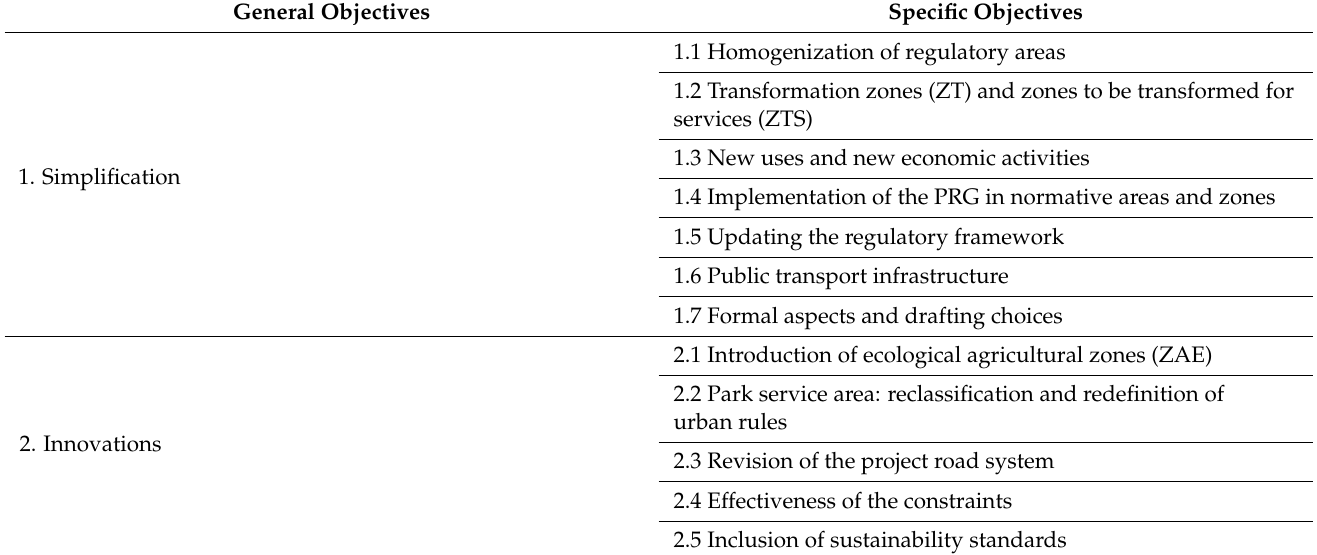
Table 11. Strategic framework of the PTPP of the Revision of the PRG